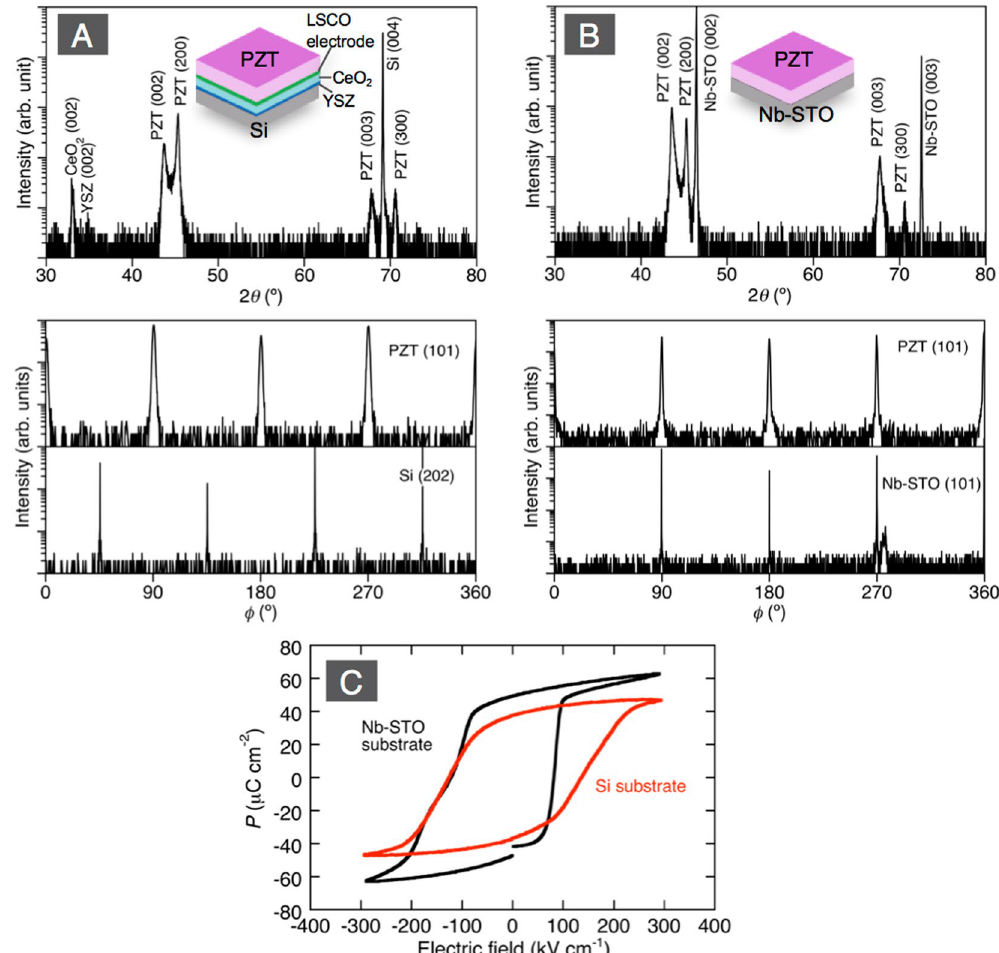
Figure 1. XRD patterns of PZT films deposited on LSCO/CeO 2 /YSZ-buffered on Si(100) ( A ) and Nb-STO (100) ( B ). The upper and lower plots show 2 θ / ω and φ scans respectively. The φ scans are of PZT(101), Si(202), and Nb-STO (101). ( C ) shows the P - E hysteresis curves of the